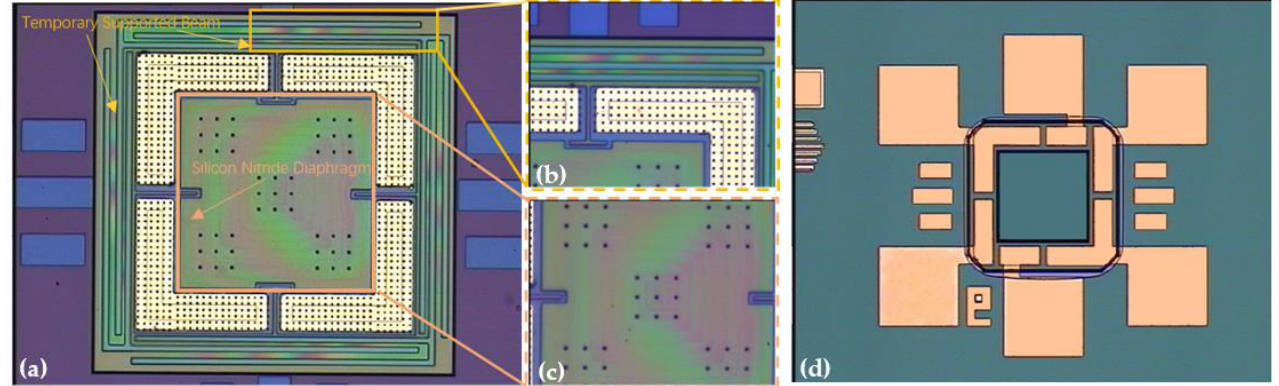
Figure 8. Optical microscope view of fabricated tactile sensor and rerouted substrate. ( a ) Optical microscope view of the fabricated tactile sensor; ( b ) enlarged optical microscope view of the temporary supported beam of the fabricated tactile sensor; ( c ) enlarged optical microscope view of the silicon nitride diaphragm of the tactile sensor; ( d ) optical microscope view of the fabricated reroute substrate.